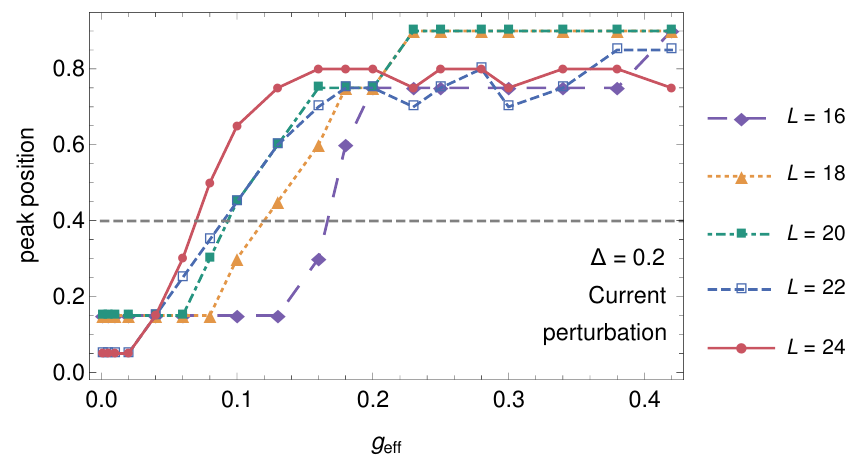
Figure 6: The position of the peak of the level spacing distribution corresponding to H for ∆ = 0.2 as a function of the effective coupling g J lengths L . The dashed grey line marks x maximum of the exact Wigner-Dyson distribution. The transition from Poissonian to Wigner-Dyson statistics is faster for longer chains, as